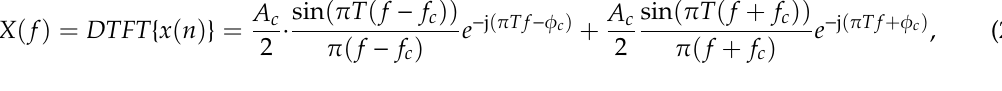
Figure 2. FFT spectra of sinusoidal waves affected by the condition of FPS.